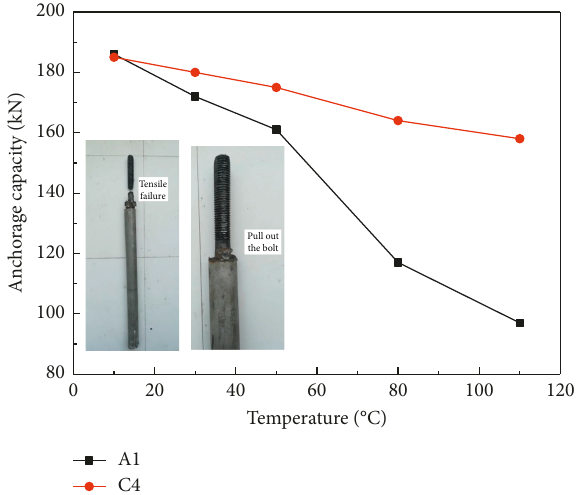
Figure 8: Variation in anchorage capacity with temperature for resin